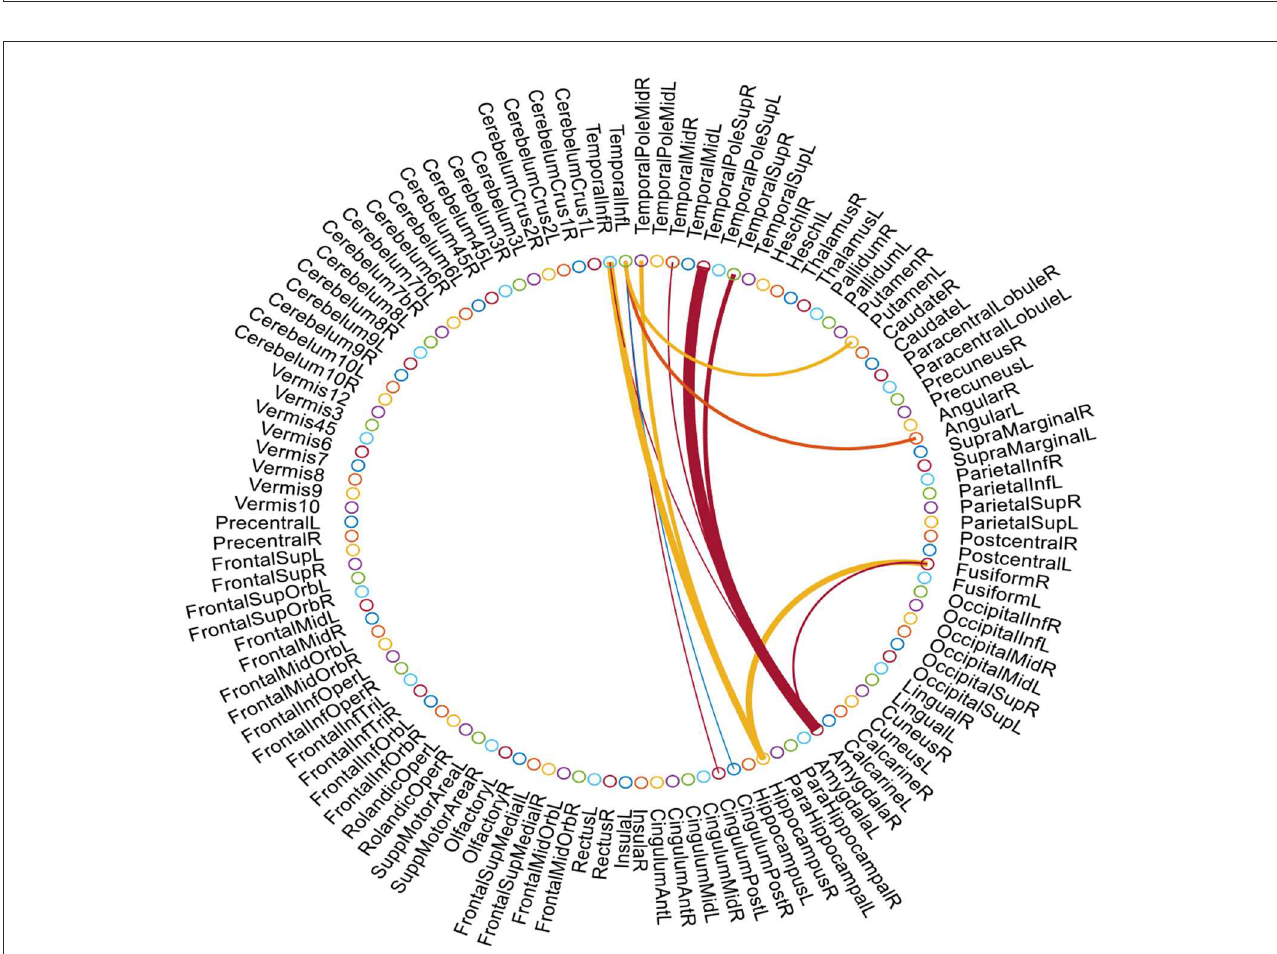
FIGURE5 Top 12 discriminative connections and ROIs in our estimated FBNs selected by t -test. The thickness of each arc denotes the discriminative power of the corresponding connection in MCI vs. NC classification.